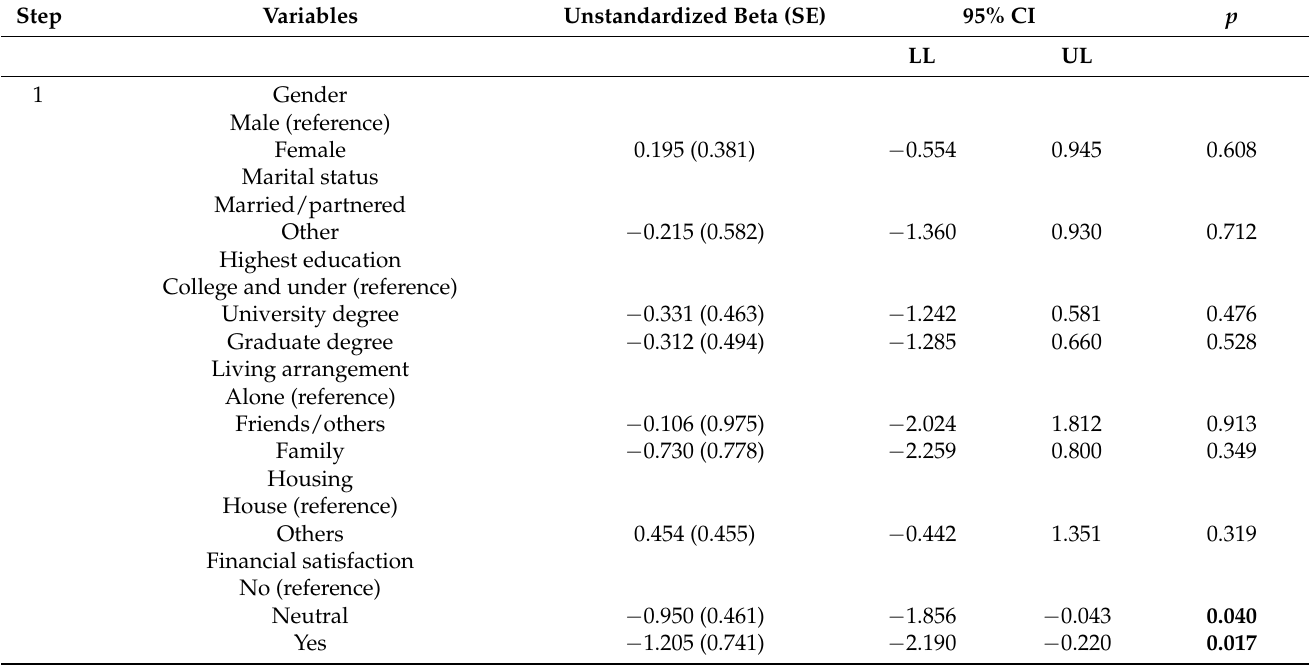
Table 3. Regression results using loneliness as the